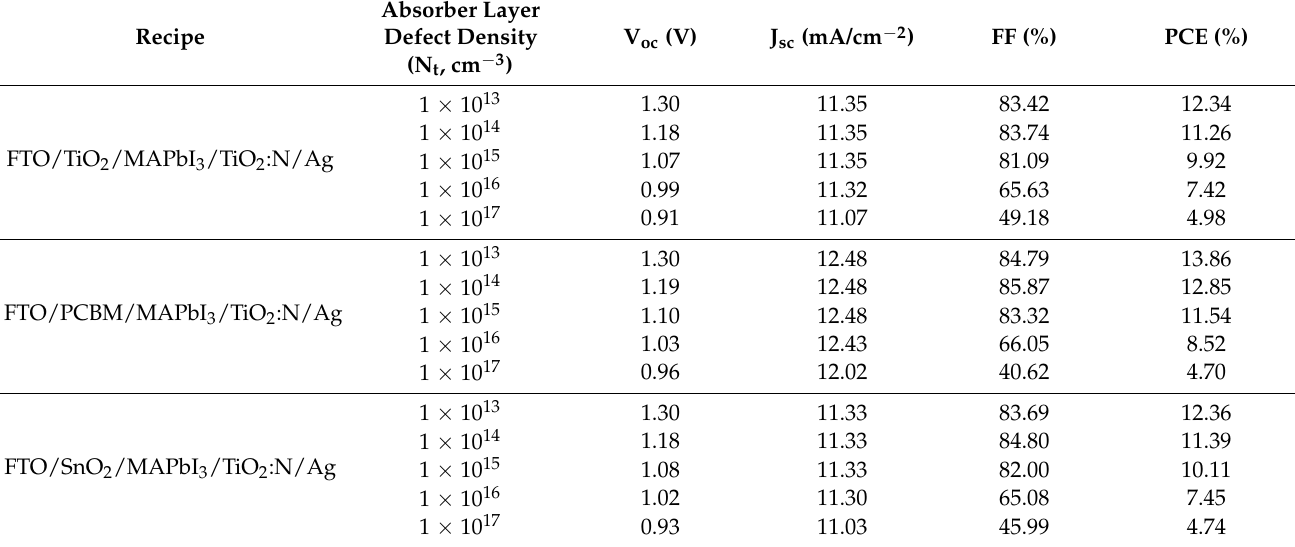
Table 4. Performance parameters for proposed recipes with a gradient in defect